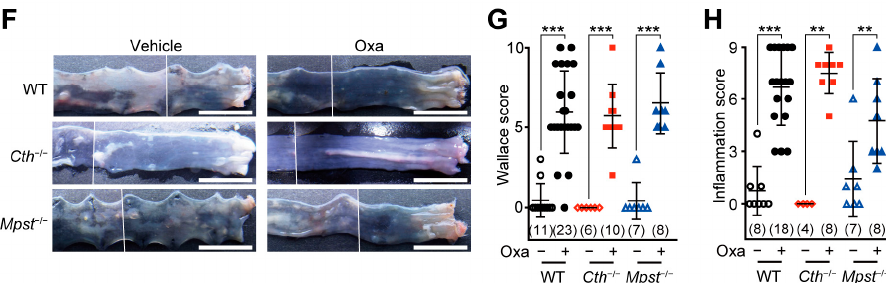
Figure 1. Two types of hapten-induced mouse IBD models: trinitrobenzene sulfonic acid (TNBS)-induced Crohn’s disease-like model ( A – D ) and oxazolone (Oxa)-induced ulcerative colitis-like model ( E – H ). ( A , E ) Experimental Design. Adult male wild-type (WT), CTH-deficient ( Cth –/– ), and MPST-deficient ( Mpst –/– ) mice were sensitized on the (dorsal or abdominal) skin and then (7 days later) challenged per rectum with those haptens. ( B – D ) Typical pictures of colonic lumens ( B ), Wallace scores ( C ), and Ameho scores ( D ), obtained with histological examination of colonic sections (Supplementary Figure S1) at day 3 after the TNBS challenge. ( F – H ) Typical pictures of colonic lumens ( F ), Wallace scores ( G ), and inflammation scores ( H ), obtained with histological examination of colonic sections (Supplementary Figure S2) at day 2 after the Oxa challenge. Data are the mean ± standard derivation (SD) with sample numbers in parentheses. Differences between non ‐ sensitized (vehicle alone) and pre ‐ sensitized (with hapten) are significant in a Mann–Whitney U test at ** p < 0.01 and *** p < 0.001 ( C , D , G , H ). Bars indicate 1 cm ( B , F ).